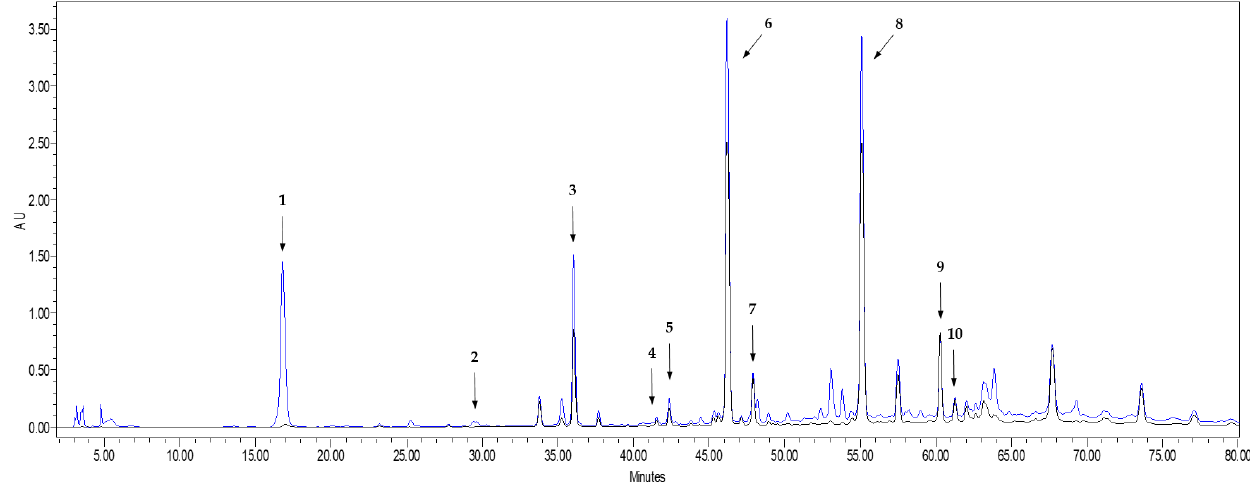
Figure 1. HPLC-UV chromatogram recorded at 254 nm (blue line) and 365 nm (black line) of the extract obtained from onion waste. Peak 1: Protocatechuic acid; Peak 2: Vanillic acid; Peak 3: Unknown flavonoid 1; Peak 4: Ellagic acid; Peak 5: Quercetin 3-glucoside; Peak 6: Unknown flavonoid 2; Peak 7: Unknown flavonoid 3; Peak 8: Quercetin; Peak 9: Kaempferol; Peak 10: Isorhamnetin.